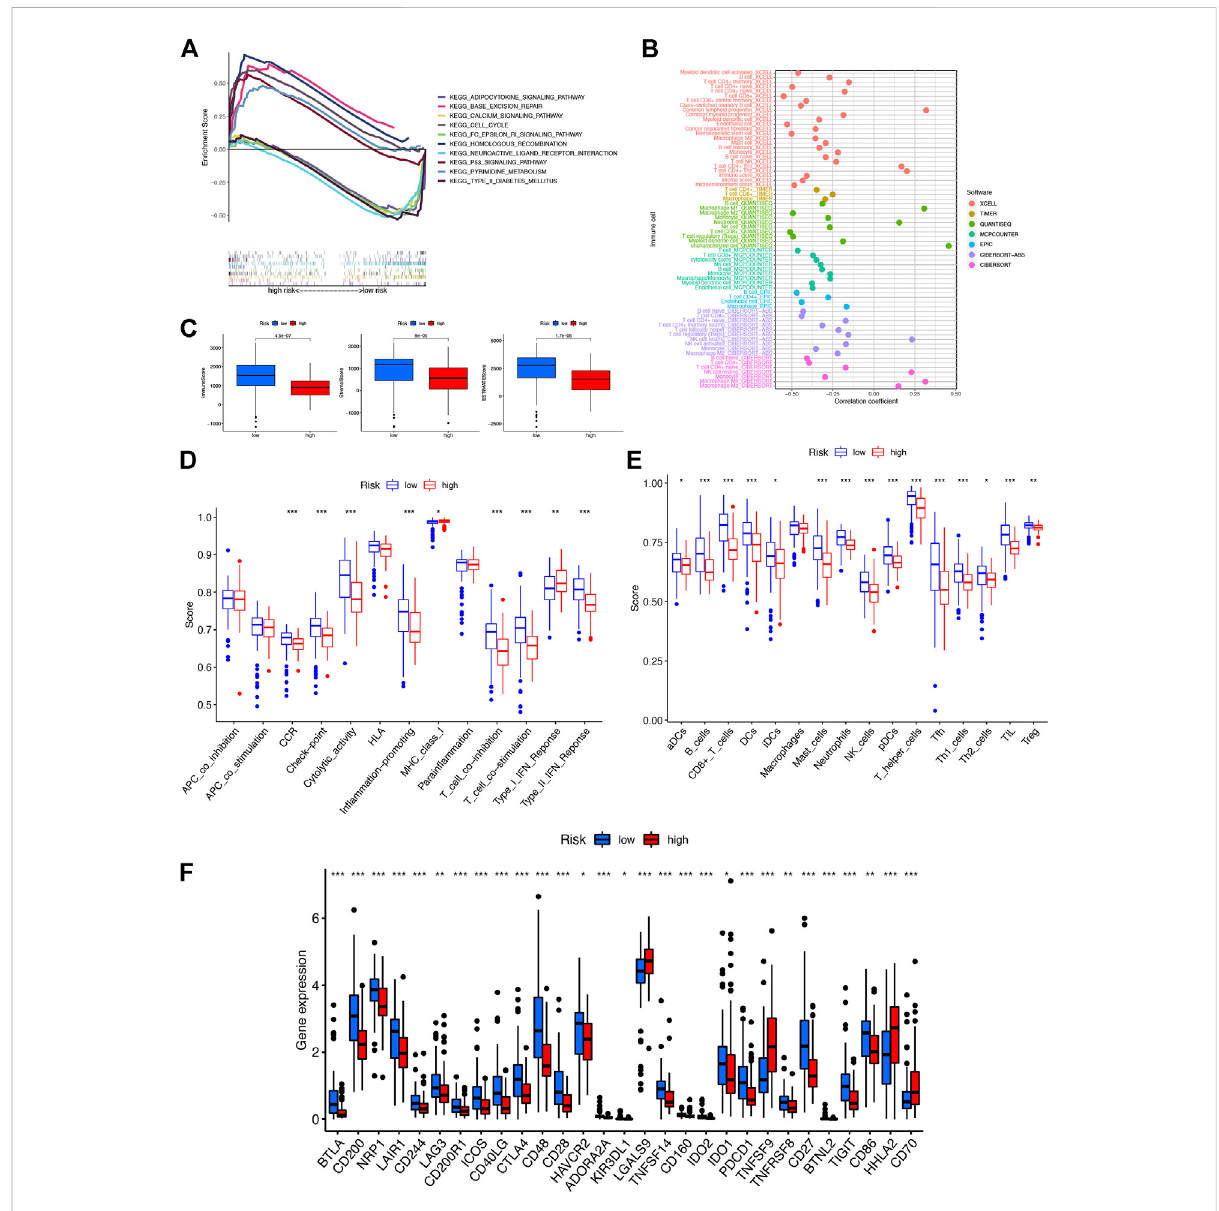
FIGURE 5 Investigationoftumorimmunefactors. (A) Top fi vepathwayssigni fi cantlyenrichedinthehigh-andlow-riskgroupswereexhibitedbyGSEA. (B) Immune cell bubble of risk groups. (C) Comparison of immune-related scores between low- and high-risk groups. (D) Difference of immune functions in risk groups. (E) Difference of immune cells in risk groups. (F) Differential expression of 29 checkpoints ’ expression in risk